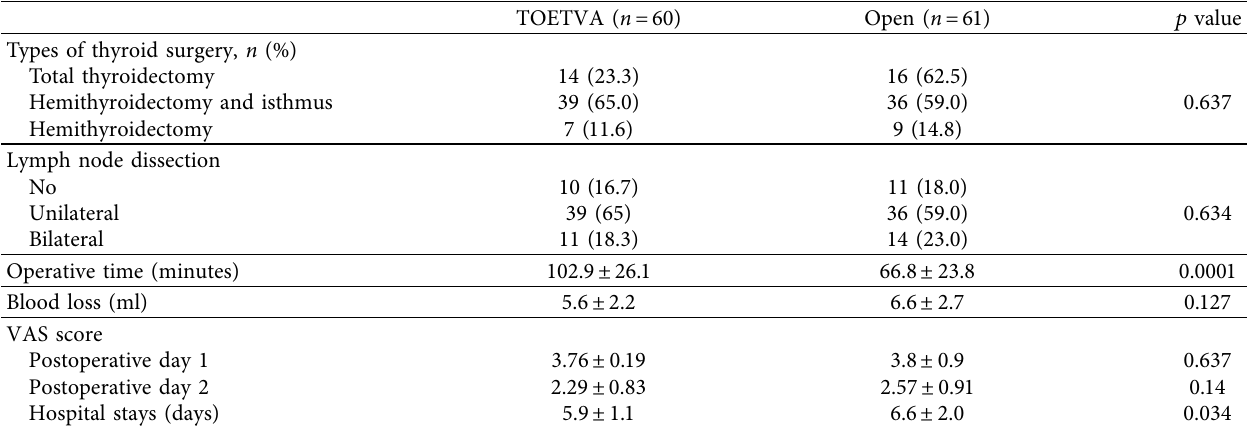
Table 2: Surgical outcomes.